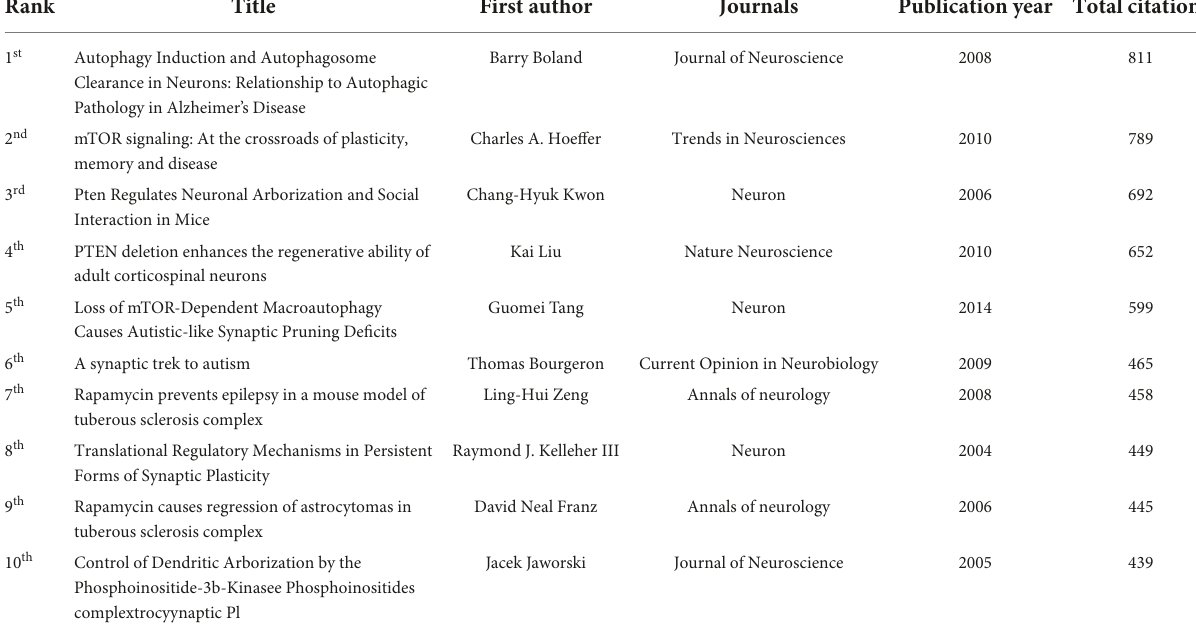
TABLE 7 Top 10 highly cited documents of mTOR in the field of